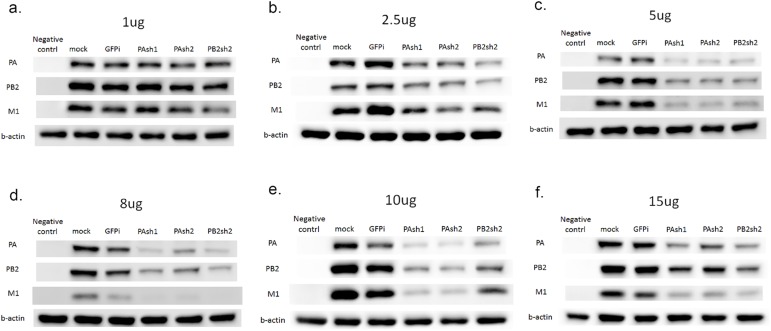
Western blot analysis for shRNAs in Vero cells with influenza A/WSN/33 virus infection.The expression levels of targeted PA, PB2, and untargeted matrix (M1) protein were analyzed by Western blot analysis. We tested treatment with (a) 1 μg, (b) 2.5 μg, (c) 5 μg, (d) 8 μg, (e) 10 μg, and (f) 15 μg of PAsh1, PAsh2, and PB2sh2 shRNA plasmids. The protein expression of the three proteins decreased in a dose-dependent pattern and reached a maximal inhibitory effect at 10 μg.